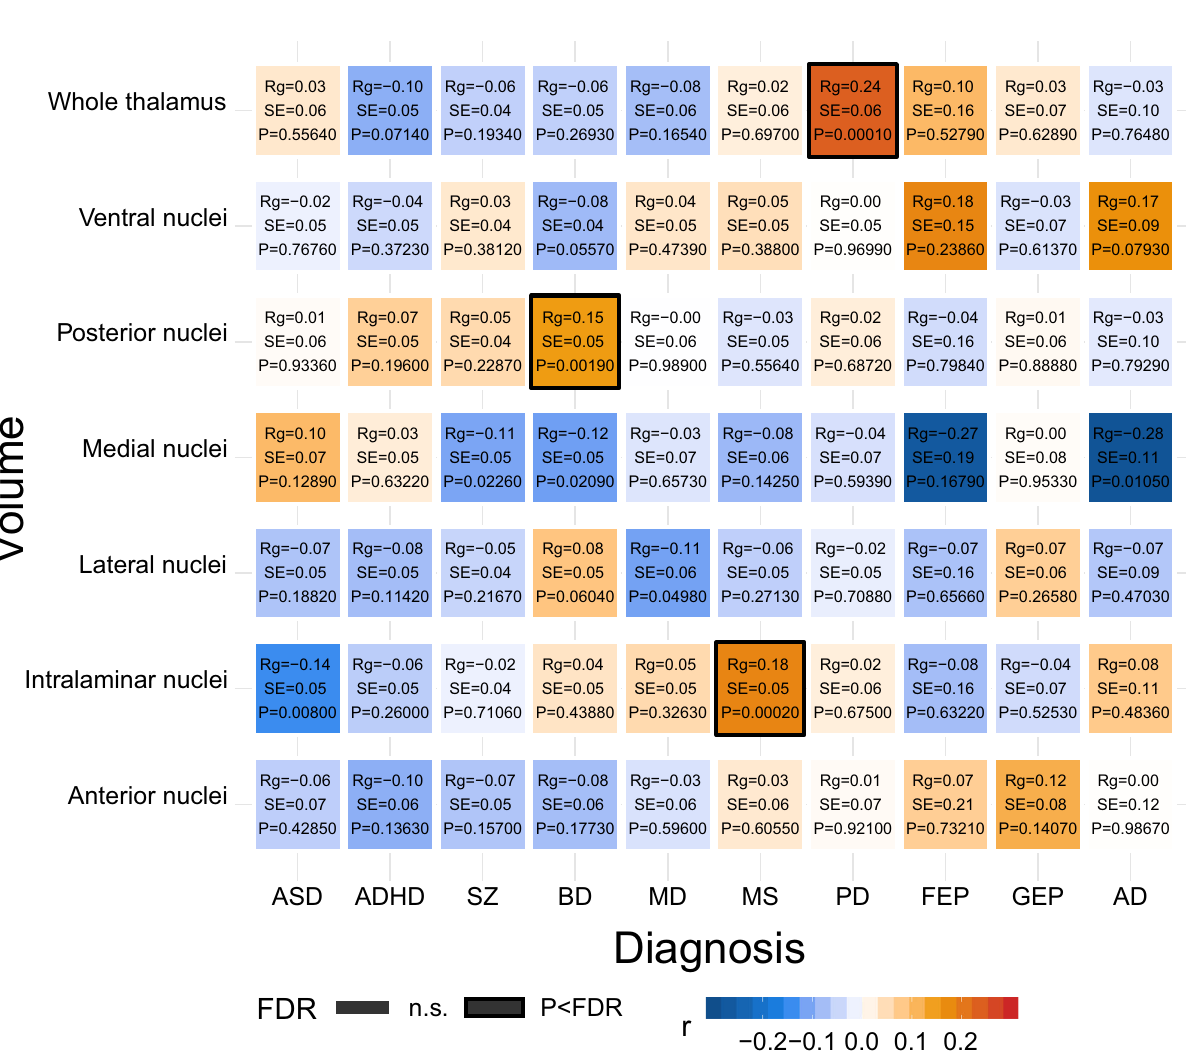
Fig. 4 LD-score regression-based genetic correlations between thalamic volumes and ten brain disorders. We assessed genetic correlations between thalamic volumes and ten brain disorders using LD-score regression. Warm and cool colors indicate positive and negative genetic associations, respectively. There were signi fi cant positive correlations between the whole thalamus and PD, between posterior nuclei and BD, and between intralaminar nuclei and MS, as indicated by a black frame, after FDR correcting across all 70 analyses (7 volumes x 10 disorders; two-sided P < FDR). AD; Alzheimer ’ s disease. ADHD; attention-de fi cit hyperactivity disorder. ASD, autism spectrum disorder; BD, bipolar disorder; FDR, false discovery rate; FEP, focal epilepsy; GEP, generalized epilepsy; MD, major depression; MS, multiple sclerosis; PD, Parkinson ’ s disease; SCZ,